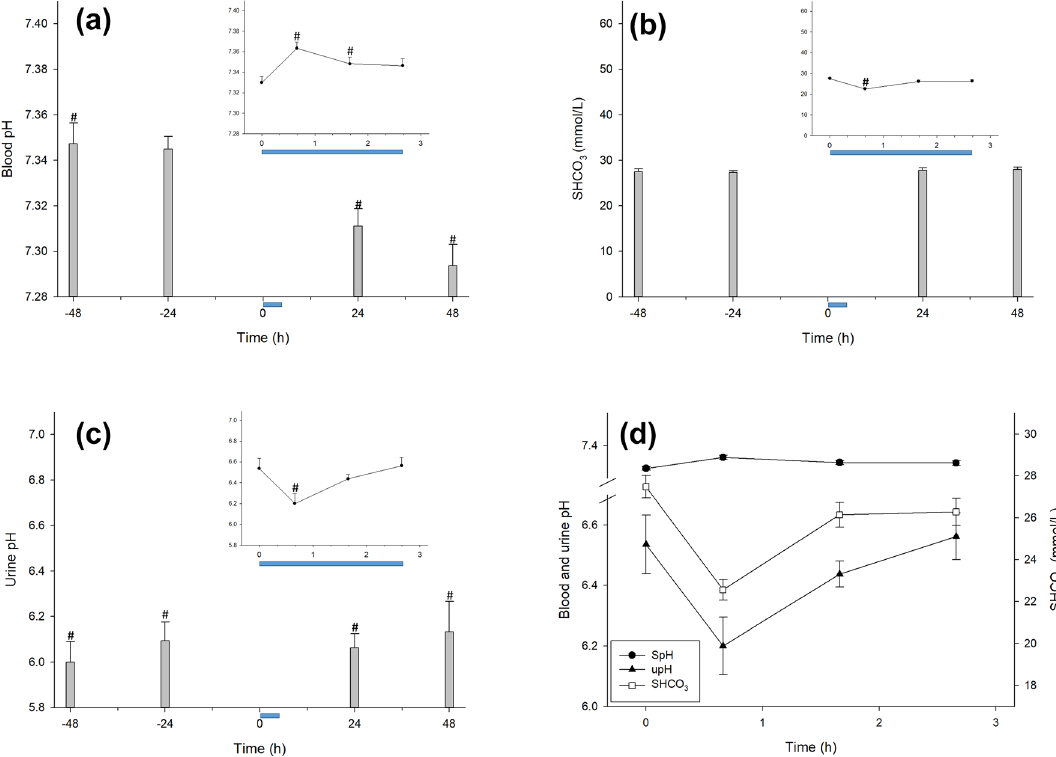
Figure 6. Blood pH did not change physiologically due to the CCombat protocol, although serum bicarbonate and urinary pH decreased. ( a ) Blood pH (SpH) #Pre vs . − 48 h: p = .046; effect size = 0.5; statistical power = 0.55; #Pre vs . Post: p < .001; effect size = 1.3; statistical power = 0.99; #Pre vs . + 60 min: p = .046; effect size = 0.7; statistical power = 0.76; #Pre vs . + 24 h: p = .038; effect size = 0.6; statistical power = 0.71; #Pre vs . + 48 h: p = .002; effect size = 1.1; statistical power = 0.98; ( b ) serum bicarbonate (SHCO3) #Pre vs . Post: p < .001; effect size = 2.3; statistical power = 1.00; ( c ) urine pH (upH) #Pre vs . − 48 h: p < .001; effect size = 1.4; statistical power = 0.99; #Pre vs . − 24 h: p = .002; effect size = 1.2; statistical power = 0.99; #Pre vs . Post: p = .016; effect size = 0.9; statistical power = 0.92; #Pre vs . + 24 h: p < .001; effect size = 1.4; statistical power = 0.99; #Pre vs . + 48 h: p = .014; effect size = 0.8; statistical power = 0.90 and ( d ) comparison of pH values and bicarbonate concentrations during CCombat protocol and short recovery. The blue bar represents the CCombat protocol in scale in both graphs. AVG ± SE.